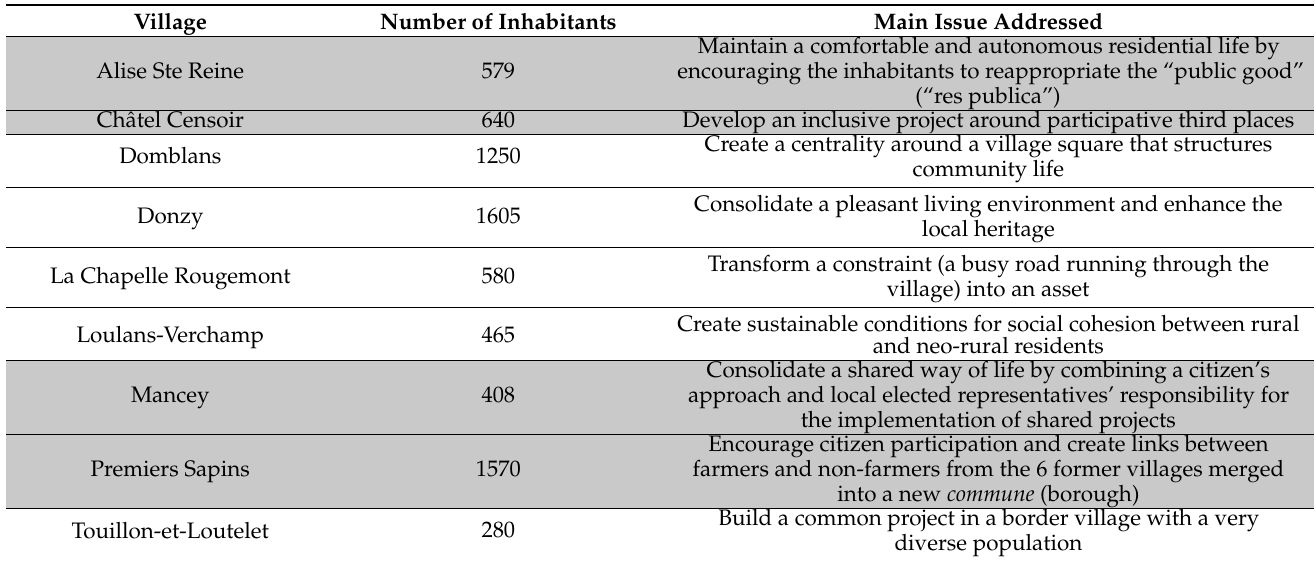
Table 1. Presentation of the 9 villages involved in the “2021 Villages of the Future”